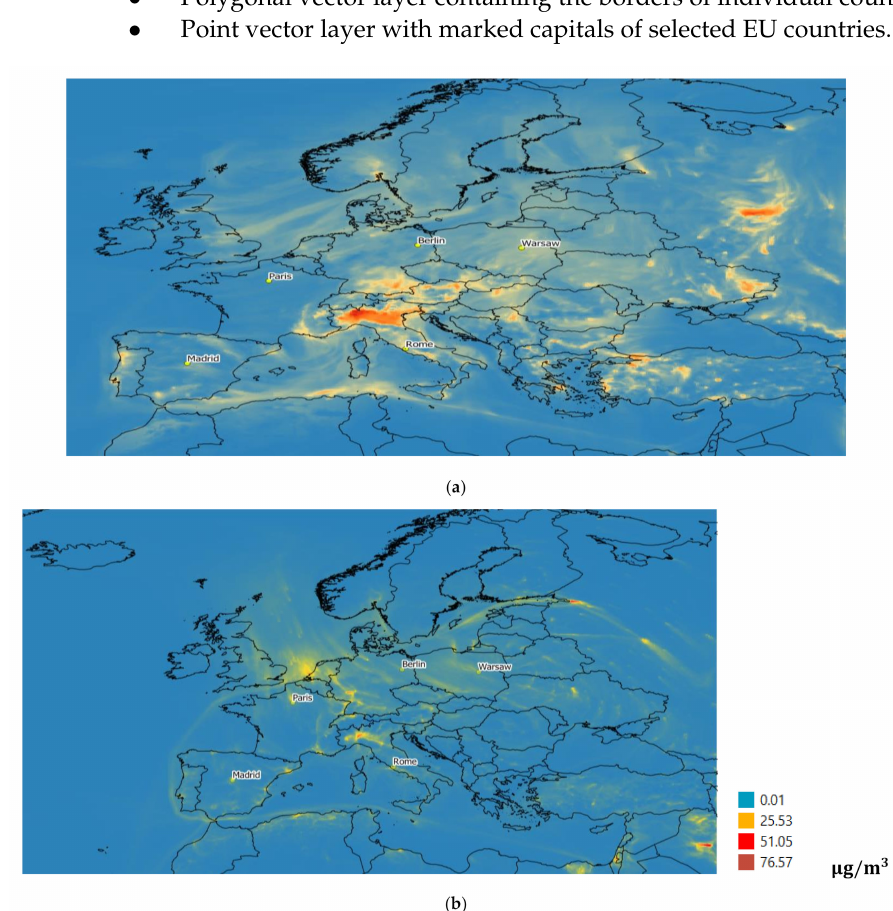
Figure 8. NO 2 concentration heat maps on ( a ) 5 April 2018 and ( b ) 5 April 2020. Source: Own elaboration, based on data from Copernicus Atmosphere Monitoring Service (CAMS) [47].